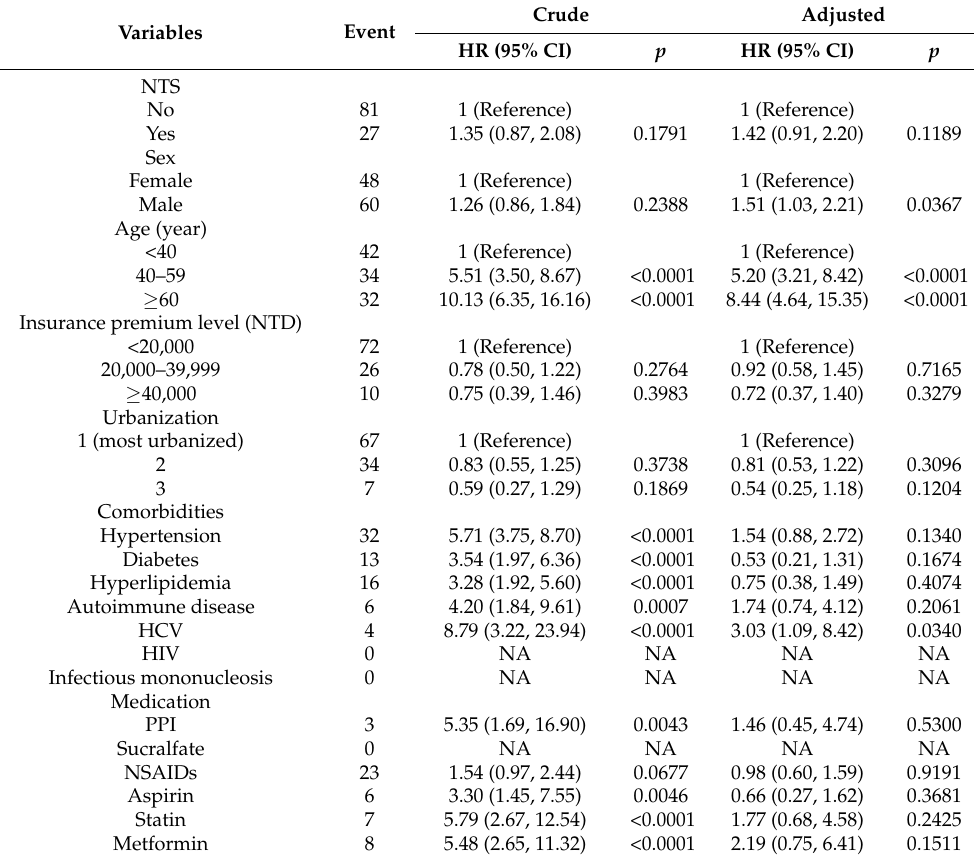
Table 2. Cox regression analyses of risk factors associated with hematological malignancy among patients in Taiwan.